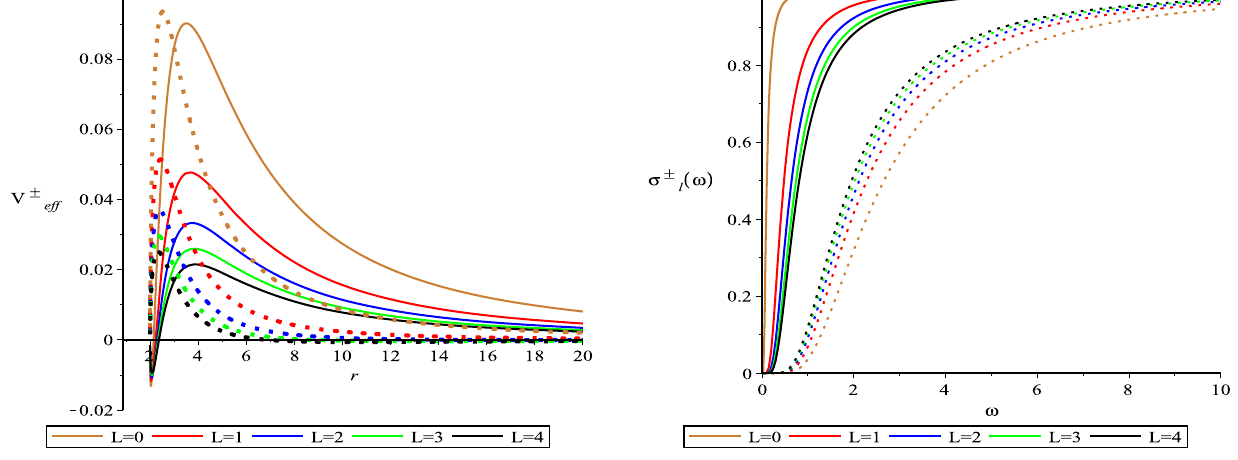
(ω) versus ω for spin- ± 1 Fig. 4 Plot of σ ± )(up/down)particles. particles. While the solid l 2 2 lines stand for the spin-up particles, the dots are for the spin-down particles. The physical parameters are chosen as follows: M = r = 1 and λ = − 1 .